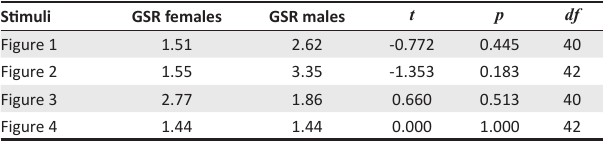
TABLE 6: Galvanic skin response results: Gender comparison of pictures versus text.